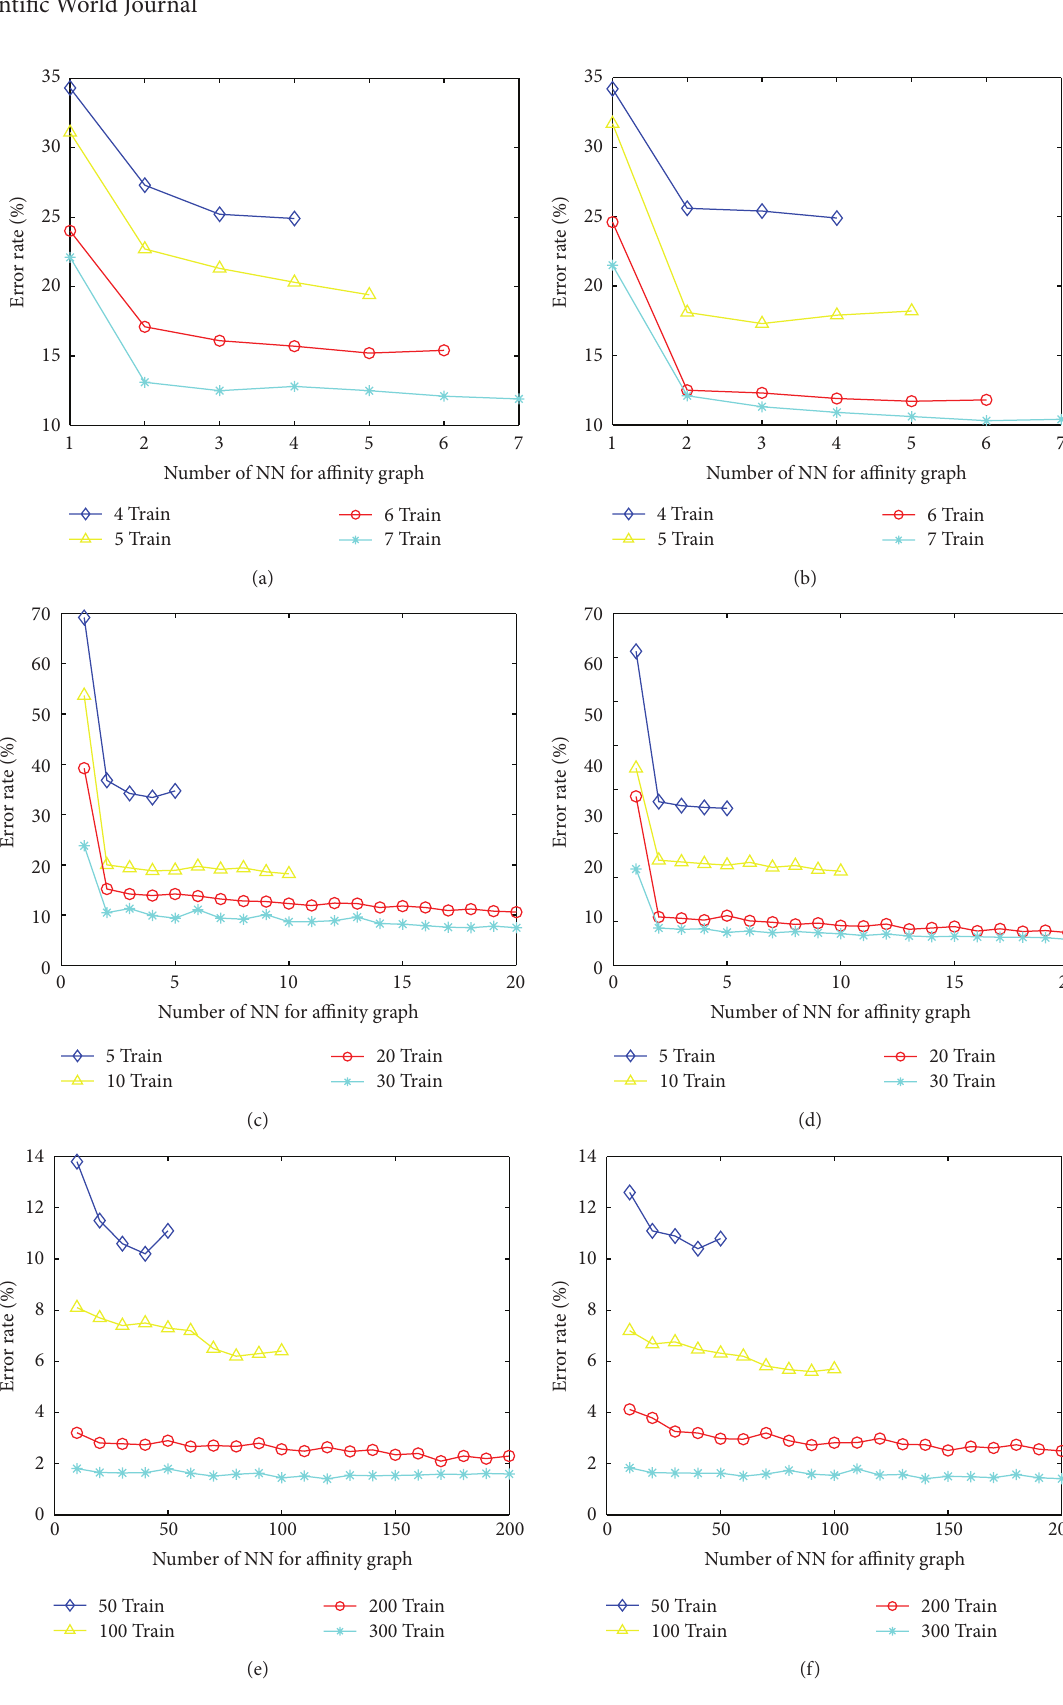
Figure 4: The behavior of the proposed methods under various 𝑘 1 . (a) CSML on Yale database, (b) KCSML on Yale database, (c) CSML on CMU PIE database, (d) KCSML on CMU PIE database, (e) CSML on MNIST database, and (f) KCSML on MNIST